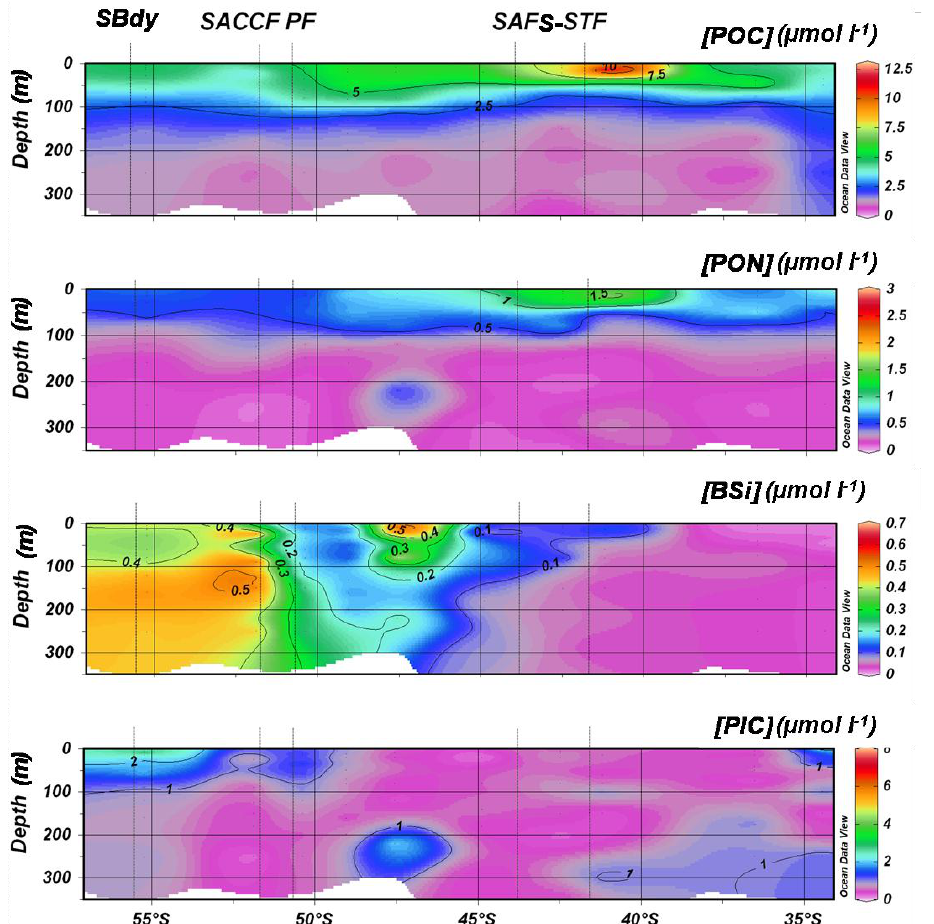
Fig. 5. Contour plots of particulate organic carbon (POC; µmolL − 1 ) , particulate organic nitrogen (PON; µmolL − 1 ) , biogenic silica (BSi; µmolL − 1 ) and particulate inorganic carbon (PIC; µmolL − 1 ) concentrations in the upper 350m along the MD166 BONUS-GoodHope section. Figure prepared using Ocean Data View (Schlitzer,